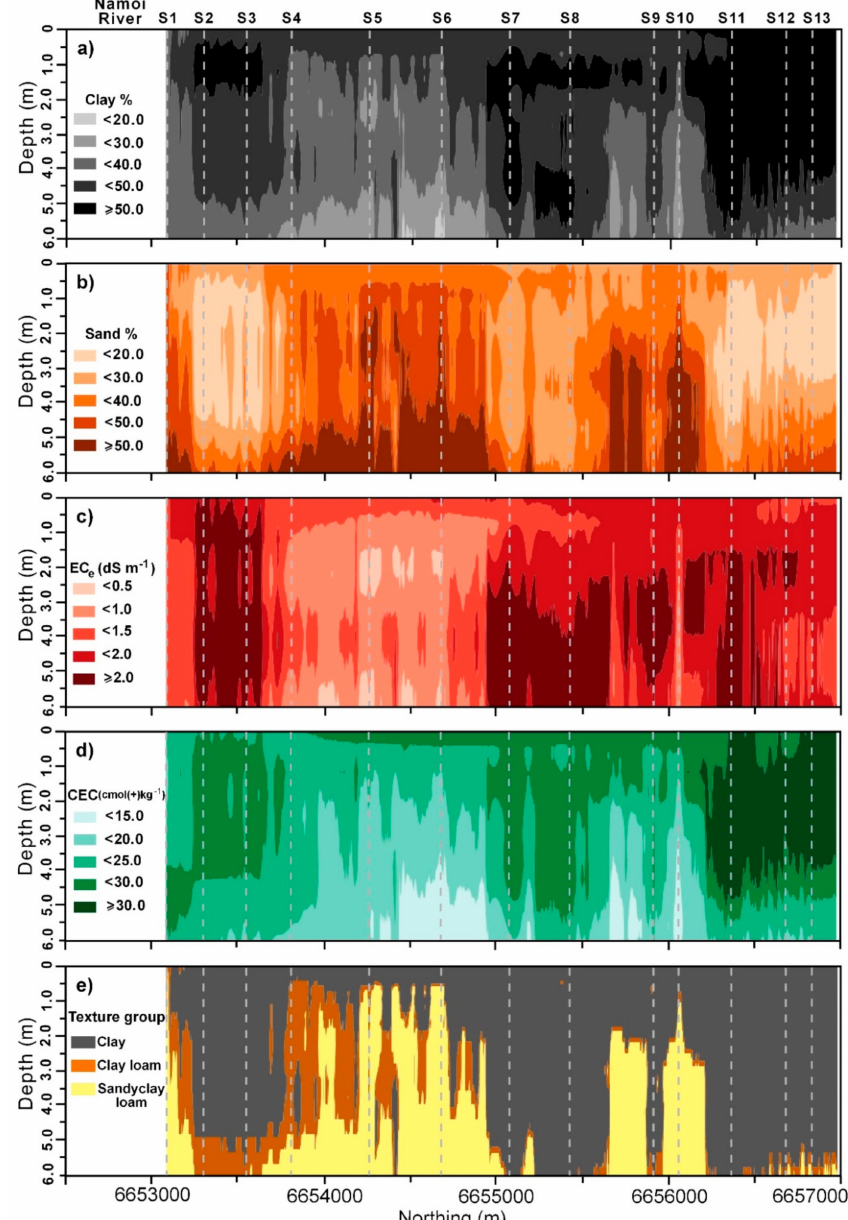
Figure 6. The spatial distribution of the predicted ( a ) clay (%), ( b ) sand (%), ( c ) electrical conductivity of a saturated soil paste extract (EC e —dS m − 1 ), ( d ) cation exchange capacity (CEC—cmol( + ) kg − 1 ) generated using a support vector machine (SVM) model and from estimates of the true electrical conductivity ( σ —mS m − 1 ) of the DUALEM-421 along with depth and ( e ) the spatial distribution with the depths of the soil texture groups calculated using the Australian textural soil classification-based predicted clay and